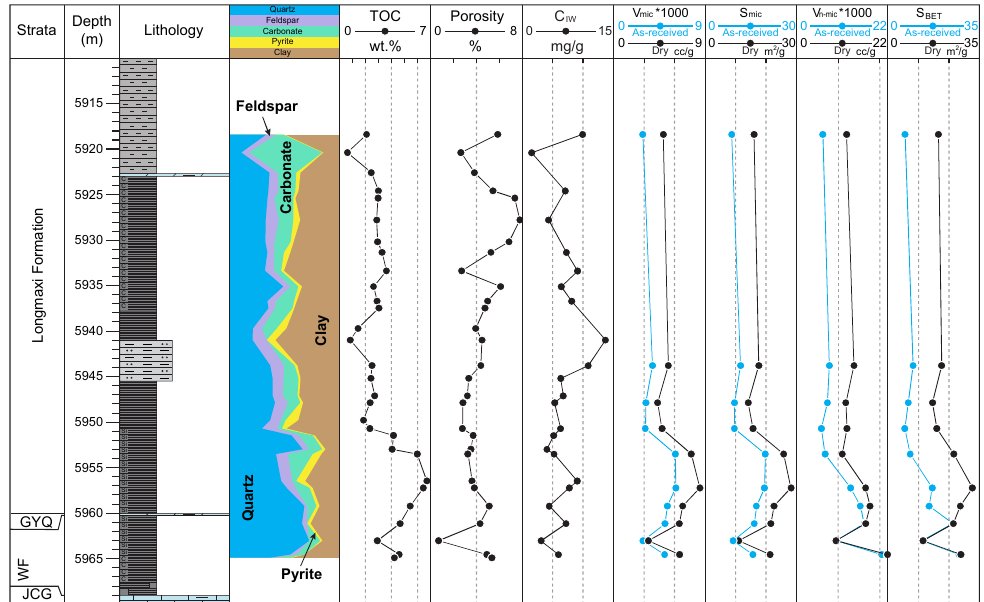
Figure 2. Vertical profiles showing mineral compositions, TOC content, porosity, irreducible water content (C IW ), as well as pore structure parameters (V mic , S mic , V n-mic , and S BET ) of the WF–LMX as-received and dry shale samples from the Well PS1.